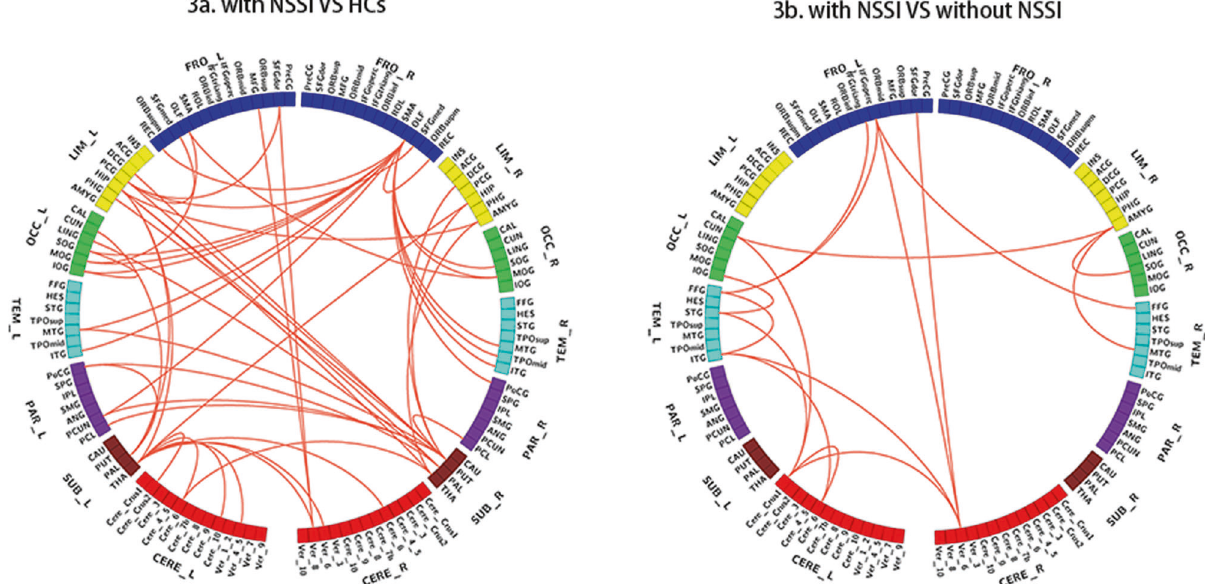
Fig. 3 Network-based statistics difference between MDD with NSSI and HCs and MDD with and without NSSI. MDD major depressive disorder, NSSI nonsuicidal self-injury, HCs healthy